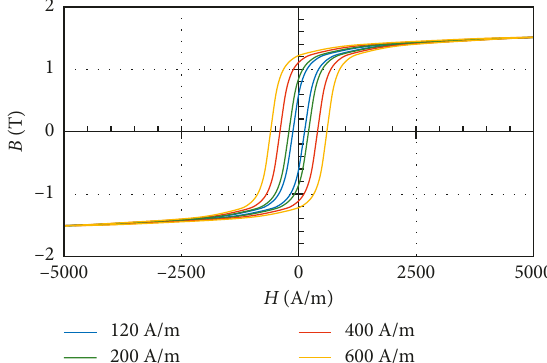
Figure 21: Coercivity: impact on the core material magnetisation characteristics